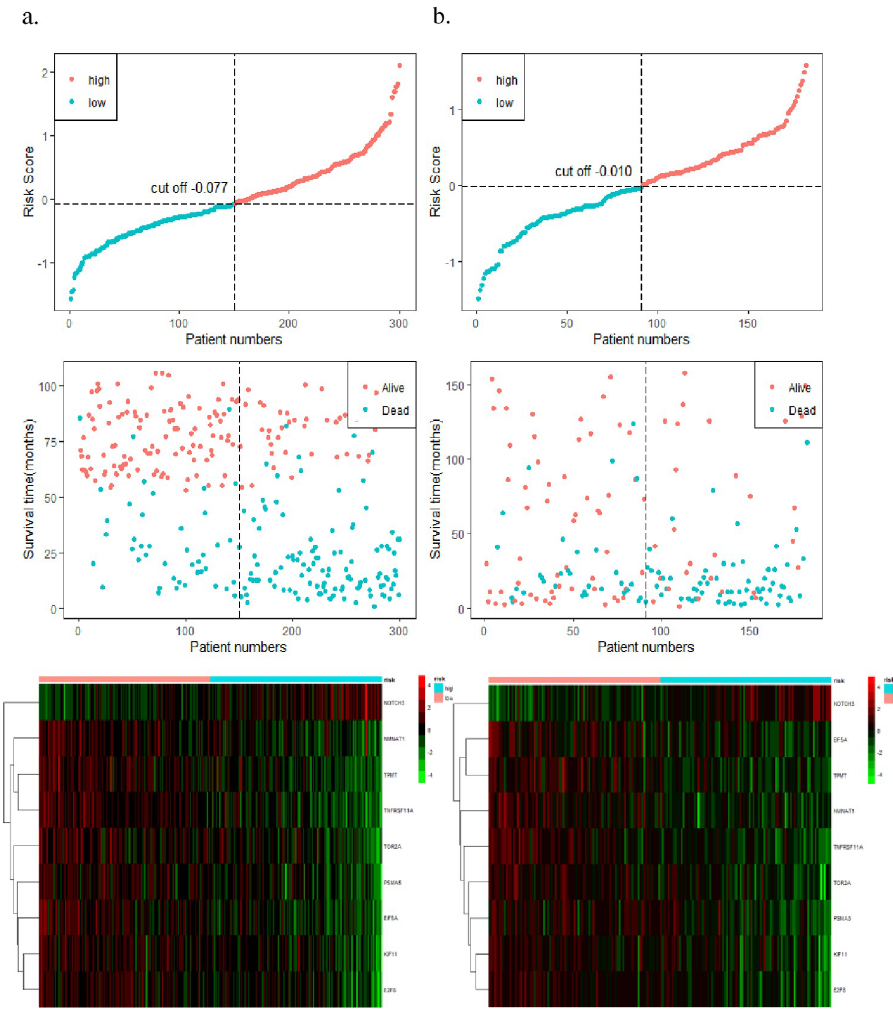
Fig 5. Risk score model based on 9 genes in the training and validation sets. a) The training set. b) The validation set. The top row shows the tendency of the risk score with the cut-off value in each dataset. The middle row shows the distribution of the survival status of patients in each dataset. The bottom row shows the mRNA expression of 9 genes based on the median risk score in each